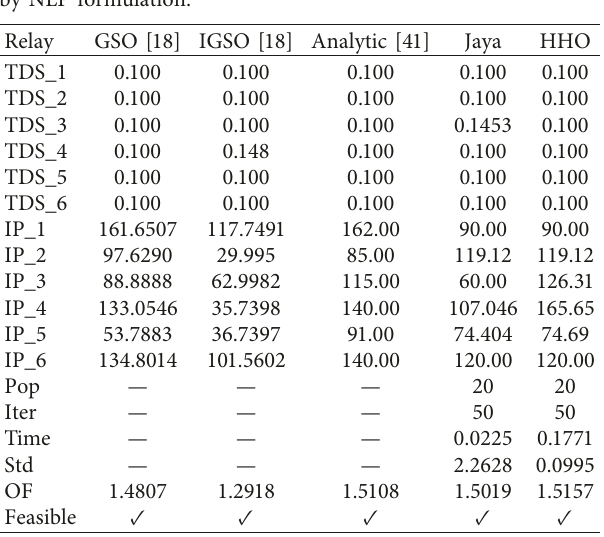
Table 4: Time dial setting and pickup current for the 3-bus system by NLP